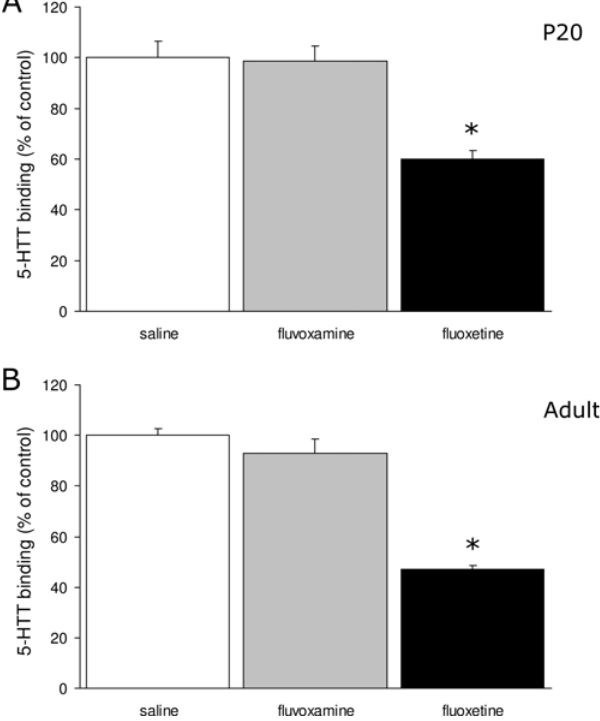
Figure 3. Binding of 5-HTT in the raphe nucleus presented as percentage of control 6 S.E.M for groups treated with saline (white bars), fluvoxamine (gray bars) and fluoxetine (black bars) at P20 (A) (N=6 for saline and fluvoxamine, N=4 for fluoxetine) and adulthood (B) (N=6 for saline and fluvoxa- mine, N=3 for fluoxetine). * p ,